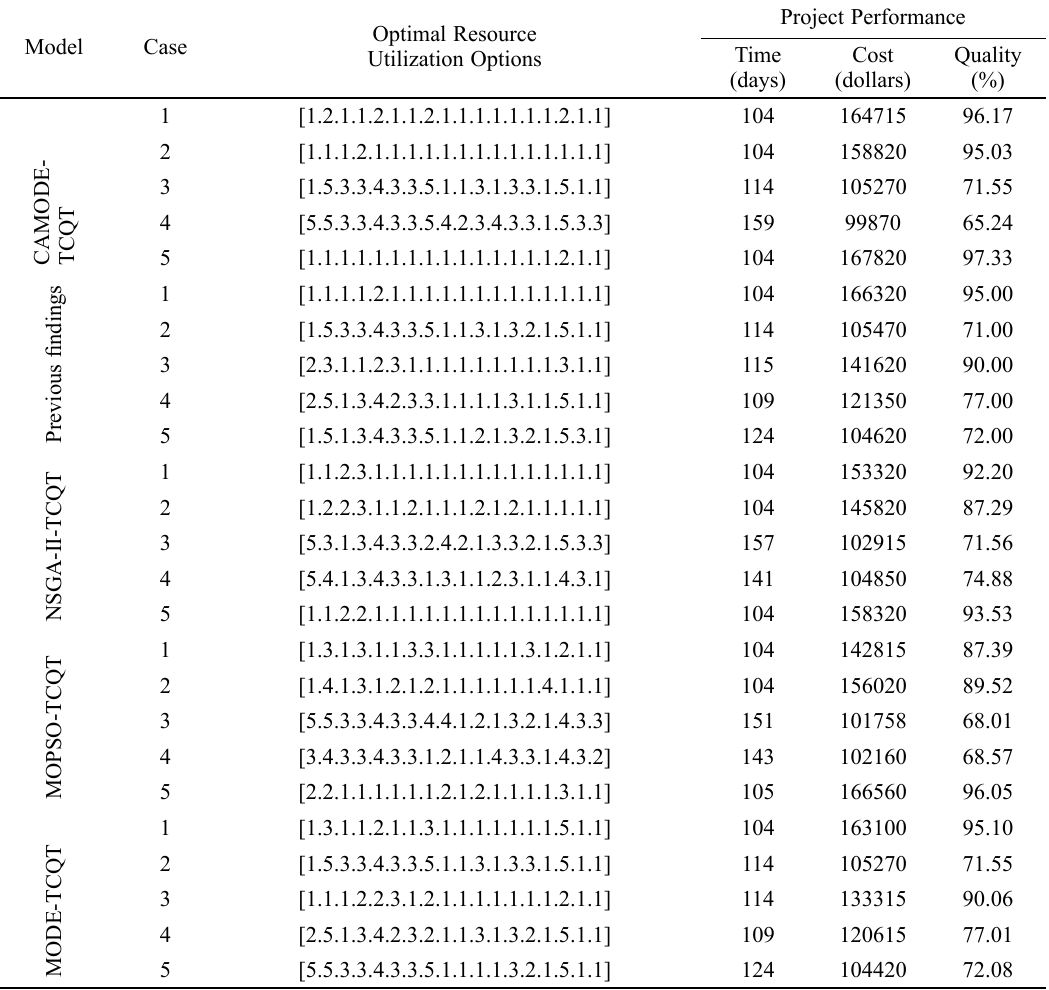
Table 4. Result comparison between CAMODE-TCQT and benchmarked algorithms